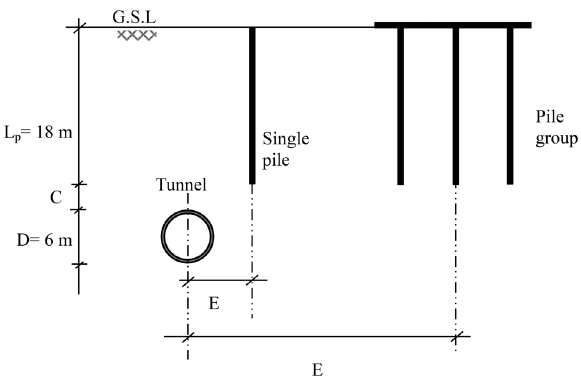
Fig. 1 3D finite element meshes, dimensions of problem and axis location used in the Figure 1: 3D finite element meshes, dimensions of problem and axis analysis location used in the analysis.